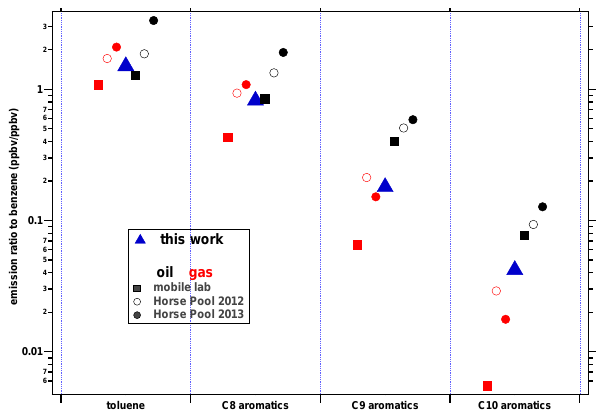
Figure 4. Comparison of emission ratio estimates. Emission ratio estimates from this analysis (blue triangle) give an average emission ratio that is partway between the oil and gas sources.